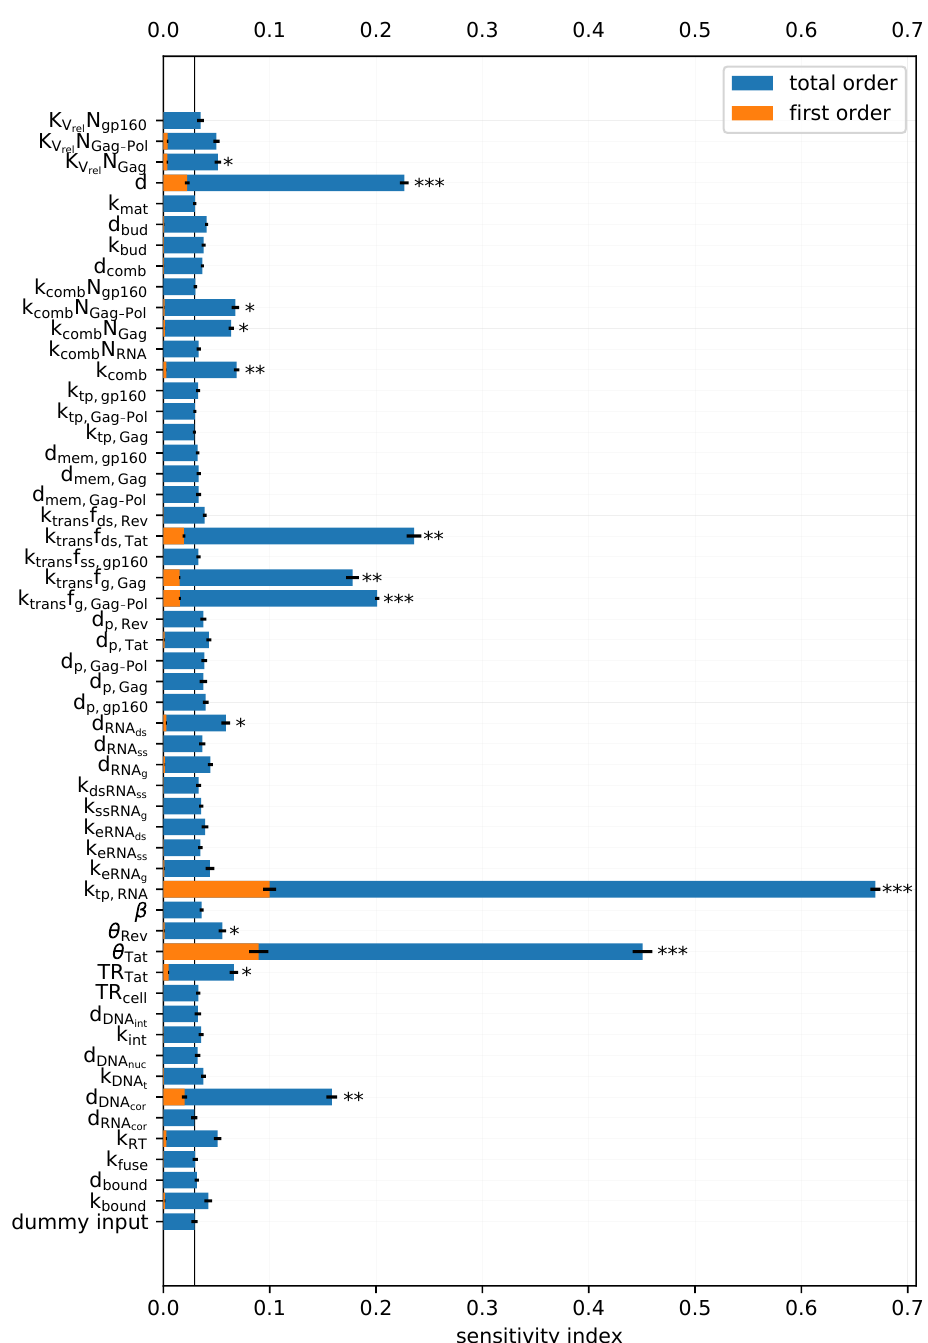
Figure 7. Sensitivity indices for the cumulative number of released virions up to 36 h computed with the deterministic model. The bars and the error bars correspond to the means ± SEMs obtained on N r = 20 resamples. The significance levels of Welch’s t -test for comparing total order indices against S total are p < 10 − 20 ( ∗∗∗ ), p < 10 − 10 ( ∗∗ ), p < 10 − 5 ( ∗ dummy